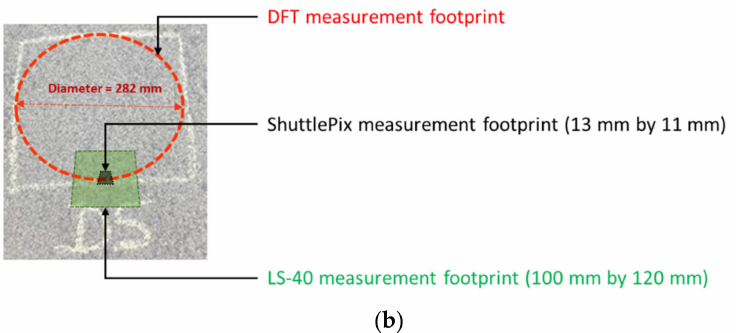
Figure 9. ( a ) Manual marking of different aggregate loss severity spots on the HFS test section and ( b ) illustration of different devices’ measurement footprint in each spot.